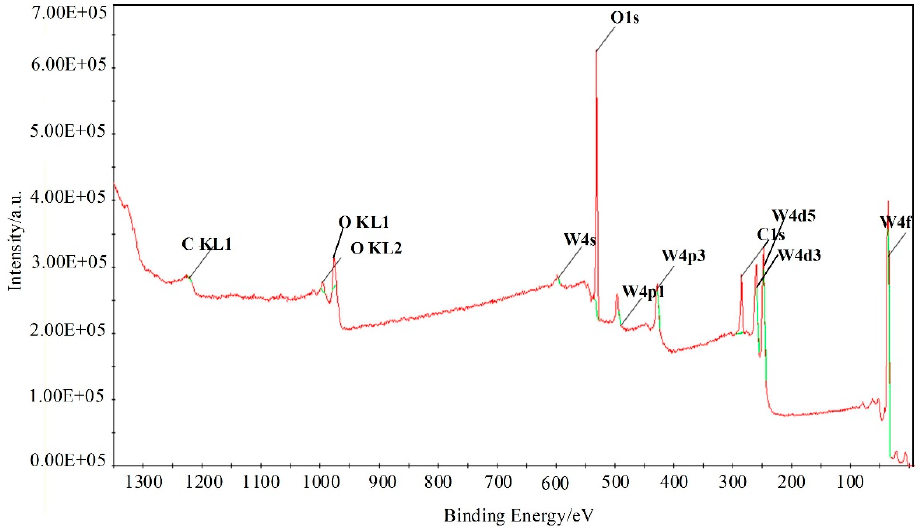
Figure 6. XPS (X-ray photoelectron spectroscopy) spectra of WG1 nanocomposites.